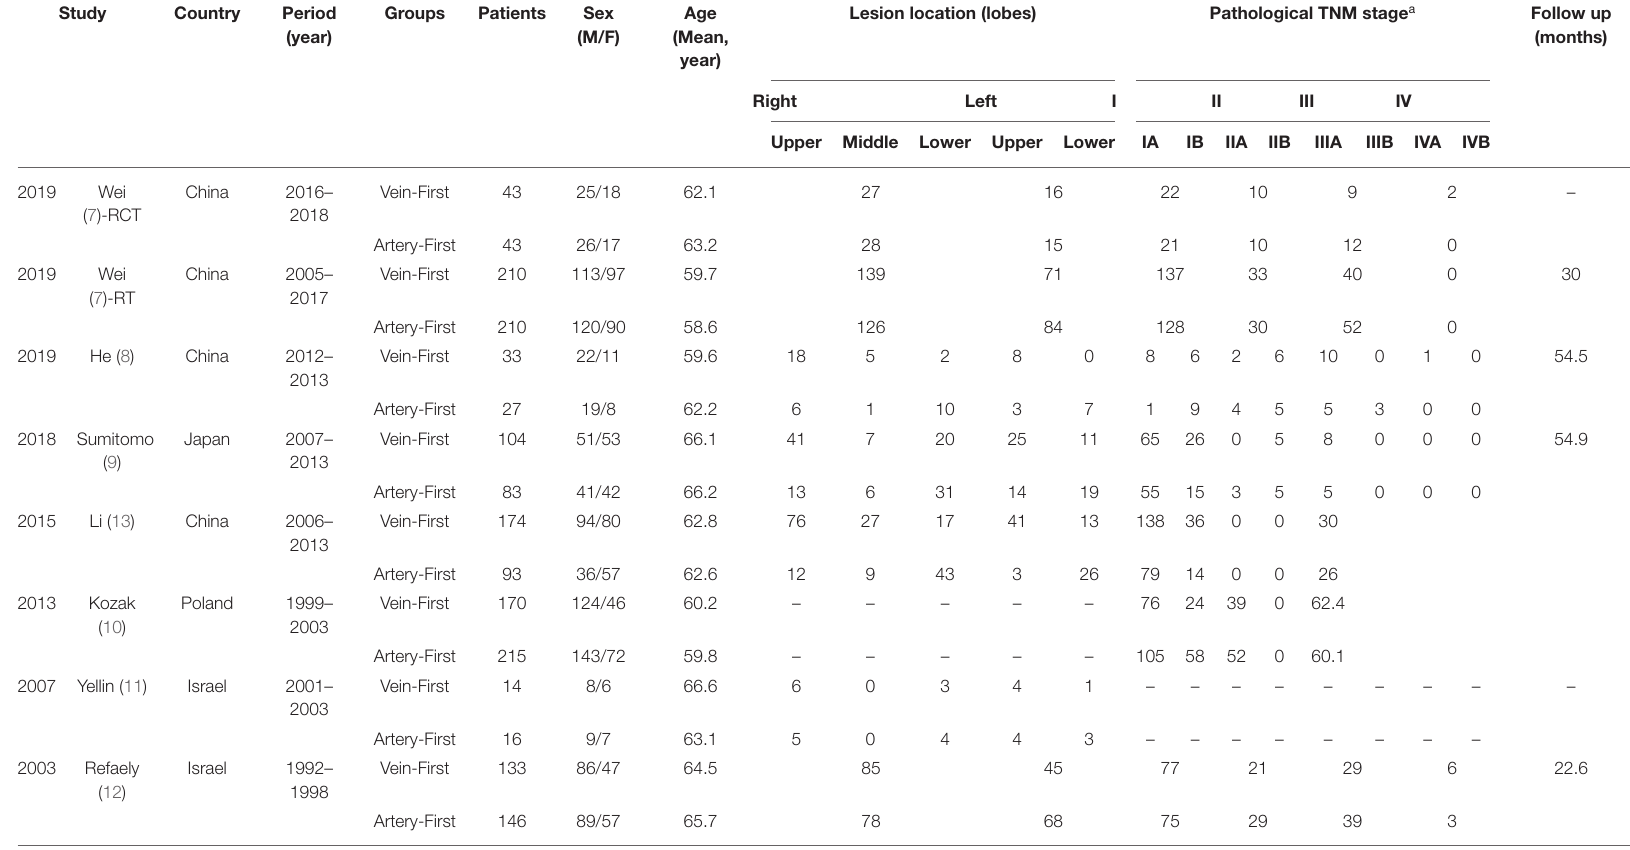
TABLE 1 | Summary of the baseline characteristics of the included